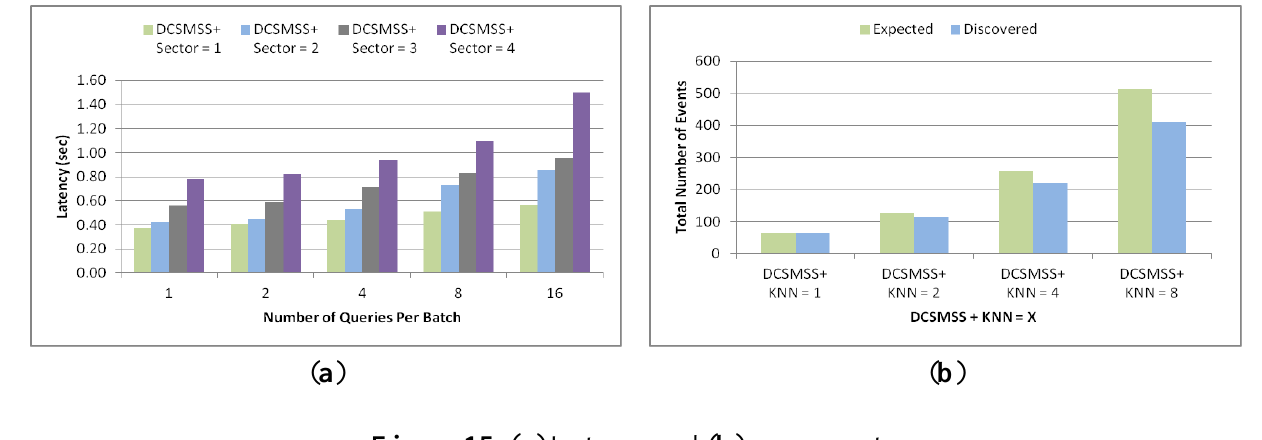
Figure 15. ( a ) Latency and ( b ) success